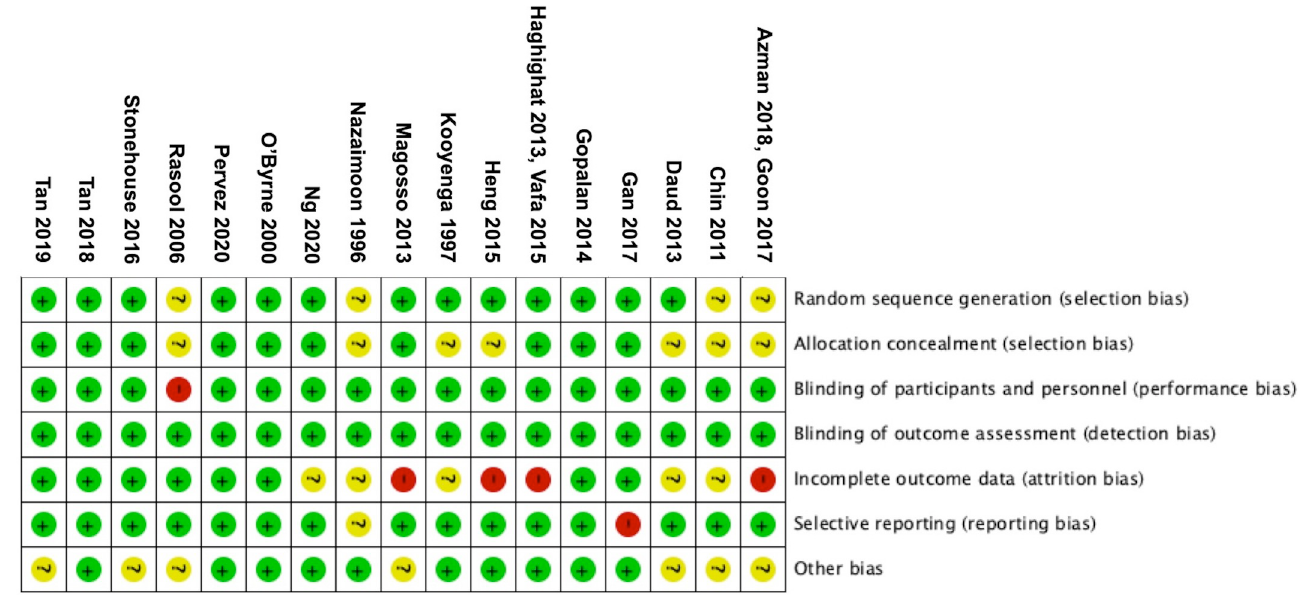
Fig 6. Risk of bias summary.